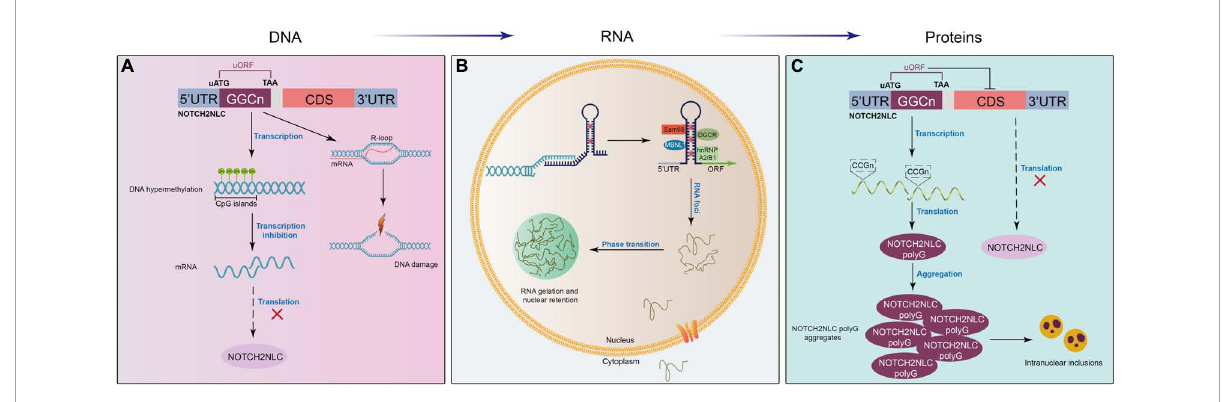
FIGURE3 Proposed mechanistic models of NIID at different levels. (A) At the DNA level, expanded GGC repeats in the NOTCH2NLC gene induce the formation of RNA-DNA hybridization R-loops during transcription, promoting DNA damage and neuronal death. In addition, the hypermethylation of the NOTCH2NLC gene leads to gene silencing and the subsequent loss of protein function. (B) After transcription, extended GGC repeats sequester many RNA-binding proteins, forming RNA foci in the nucleus and resulting in the functional loss of RNA-binding proteins. (C) GGC repeat expansion initiates a near-homologous ACG codon located upstream of the GGC repeats in the NOTCH2NLC gene and is translated into the polyglycine (polyG)-NOTCH2NLC protein, which inhibits nucleocytoplasmic transport, leading to the accumulation of polyG-NOTCH2NLC and protein